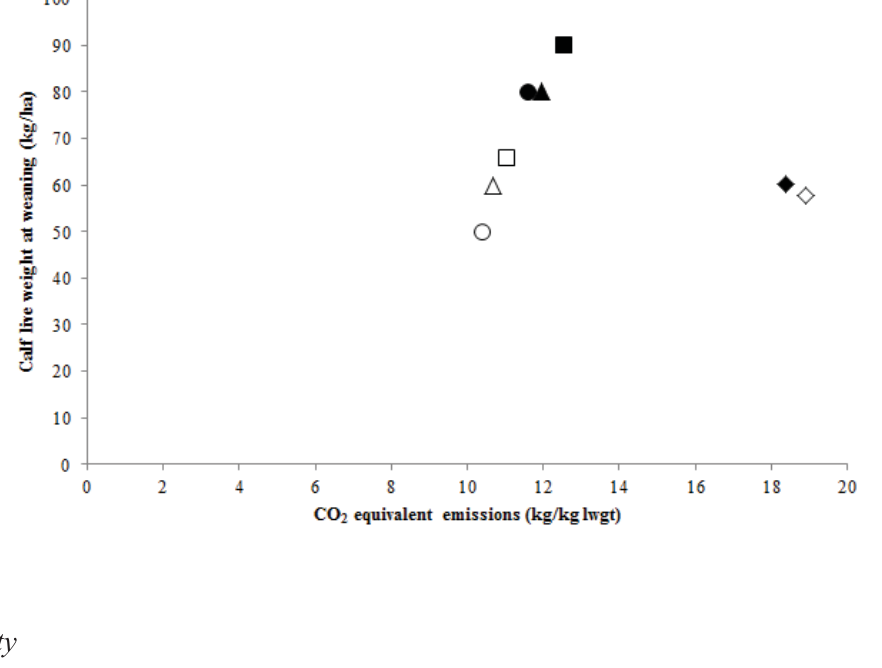
Figure 3. Predicted average annual carbon dioxide (kg CO per kg calf live weight at weaning (kg lwgt) and turnoff of calf live weight at weaning (kg) per hectare at Albany (diamond), Dookie (circle), Vasey (square) and Wagga Wagga (triangle) for the years 1971 to 2000 for cows on pasture (white symbols) or pasture and supplementary feed (black